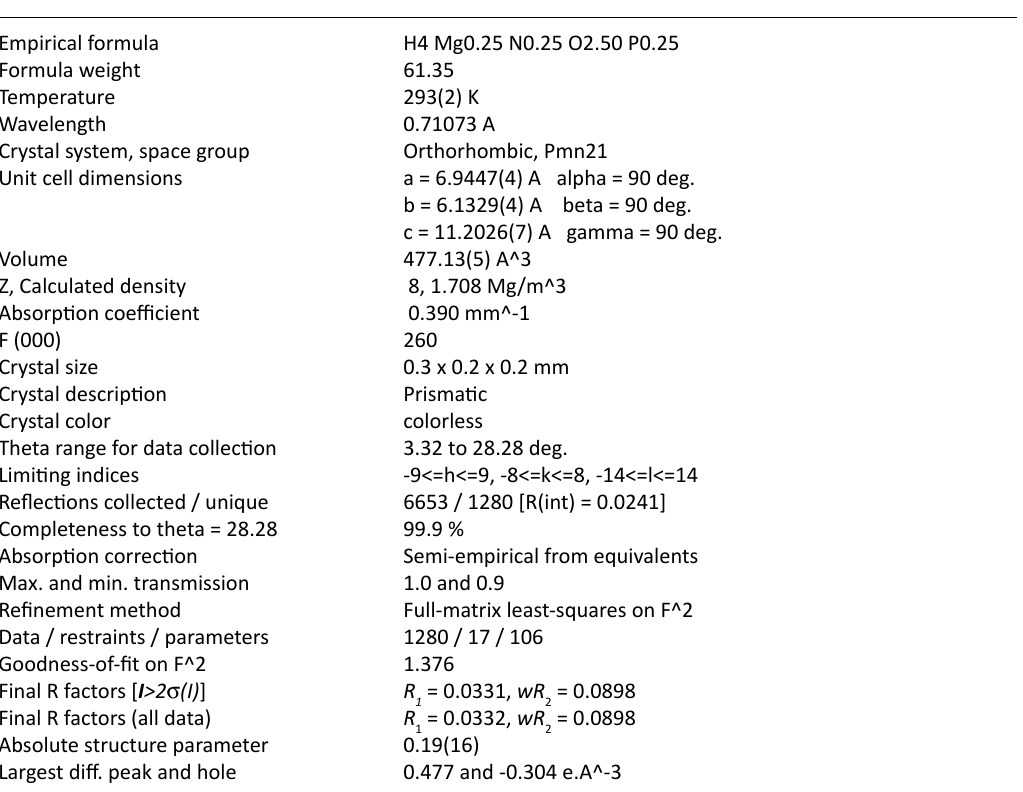
Table 2. Crystal data and structure